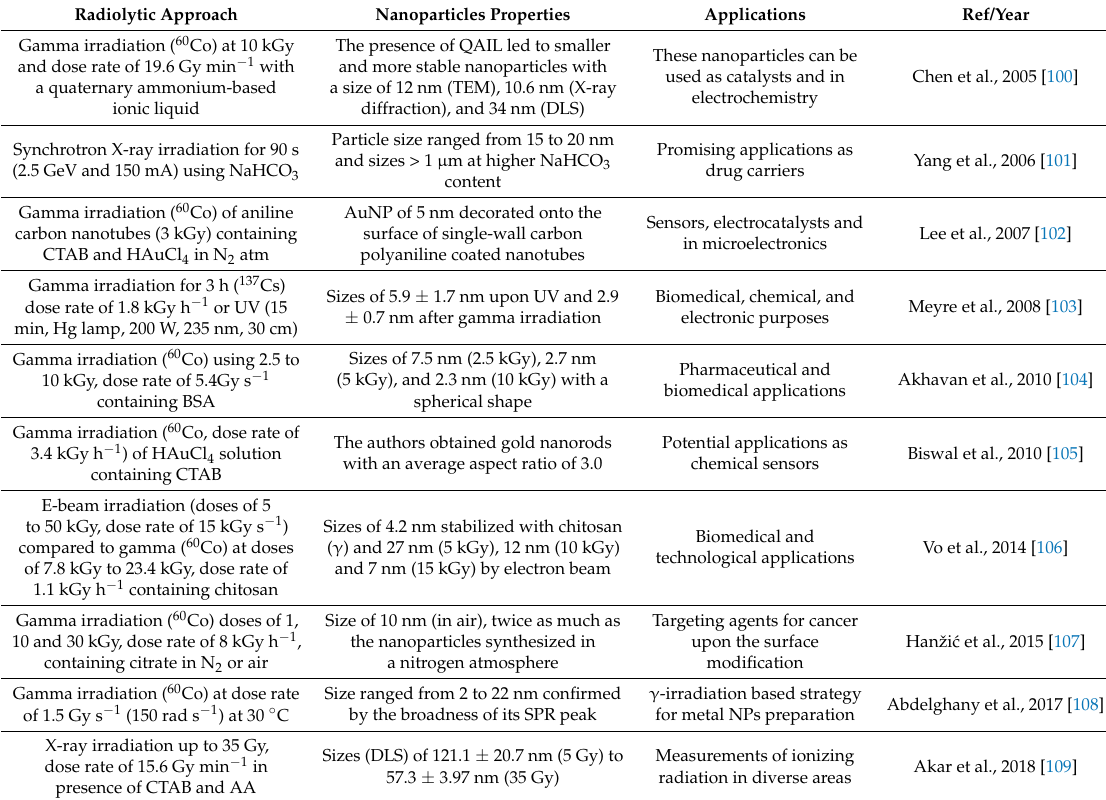
Table 2. Anupdatedreviewofgoldnanoparticlessynthesizedbyionizingradiationreportedintheliterature. Radiolytic